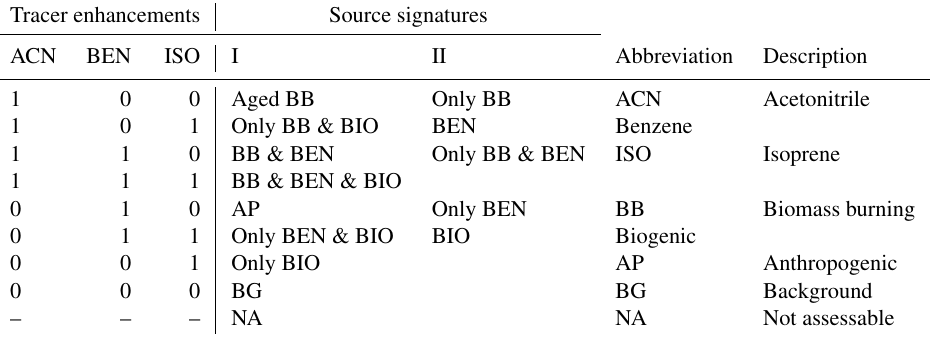
Table 3. Definition of source signatures that can be derived from measured enhancements of acetonitrile (ACN), benzene (BEN) and isoprene (ISO) above (1) or below (0) specified threshold levels (listed in Table 2). The source signatures aged BB, BB & BEN and AP are defined only based on the combination of ACN and BEN. Other signatures are based on the combination of ACN, BEN and ISO. Periods of instrumental background detection (see Sect. 3.1.1) and when tracers change between 1 and 0 (or vice versa) are excluded and indicated with NA (last